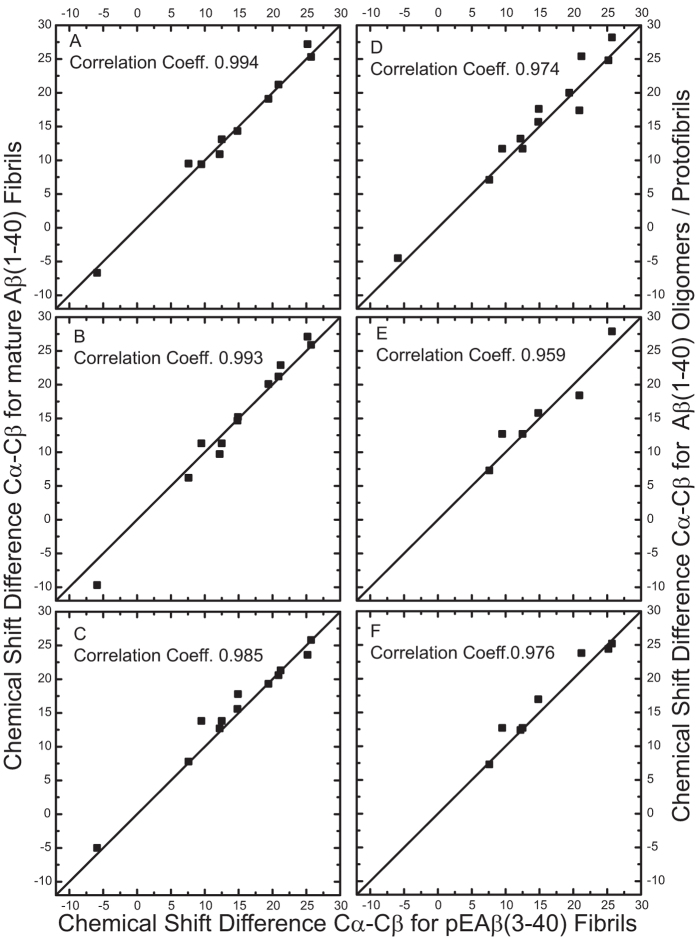
Comparison of fibrils of pGlu3-Aβ(3–40) with published chemical shift data of WT Aβ preparations.Correlation plots of the chemical shift differences (13Cα-13Cβ) for all labeled amino acids of pGlu3-Aβ(3–40) (x axis) and Aβ fibrils in different stages of the fibrillation process (y axis) are given. (A) mature fibrils from24, (B) mature fibrils16, (C) mature fibrils21, (D) protofibrils35, (E) oligomers43, and (F) oligomers44. The Pearson correlation coefficient is given for each plot. Note that Gly9 and Gly29 are not part of this comparison as 13Cα-13Cβ chemical shift differences are analyzed.